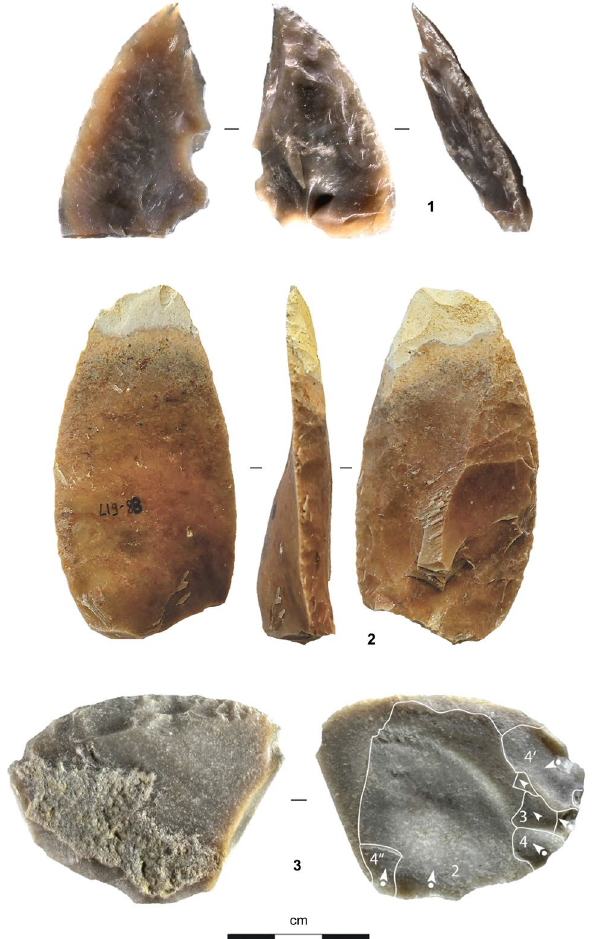
Figure 6. Stone tools (layer III-i/j, lens III-i/j2-3). 1–2. Sidescrapers (chert); 3. Kombewa core on broken sidescraper